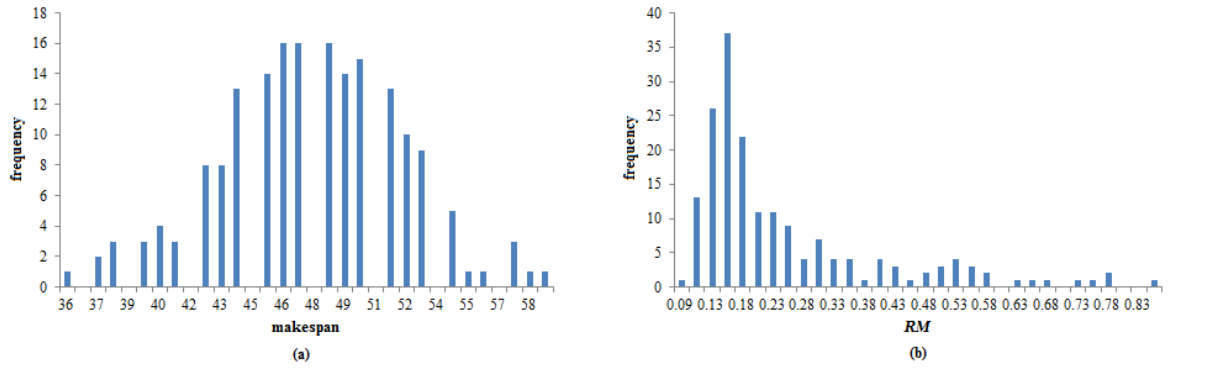
Fig.9 Distribution of makespan and RM when OS = 0.1 and RC = 0.1